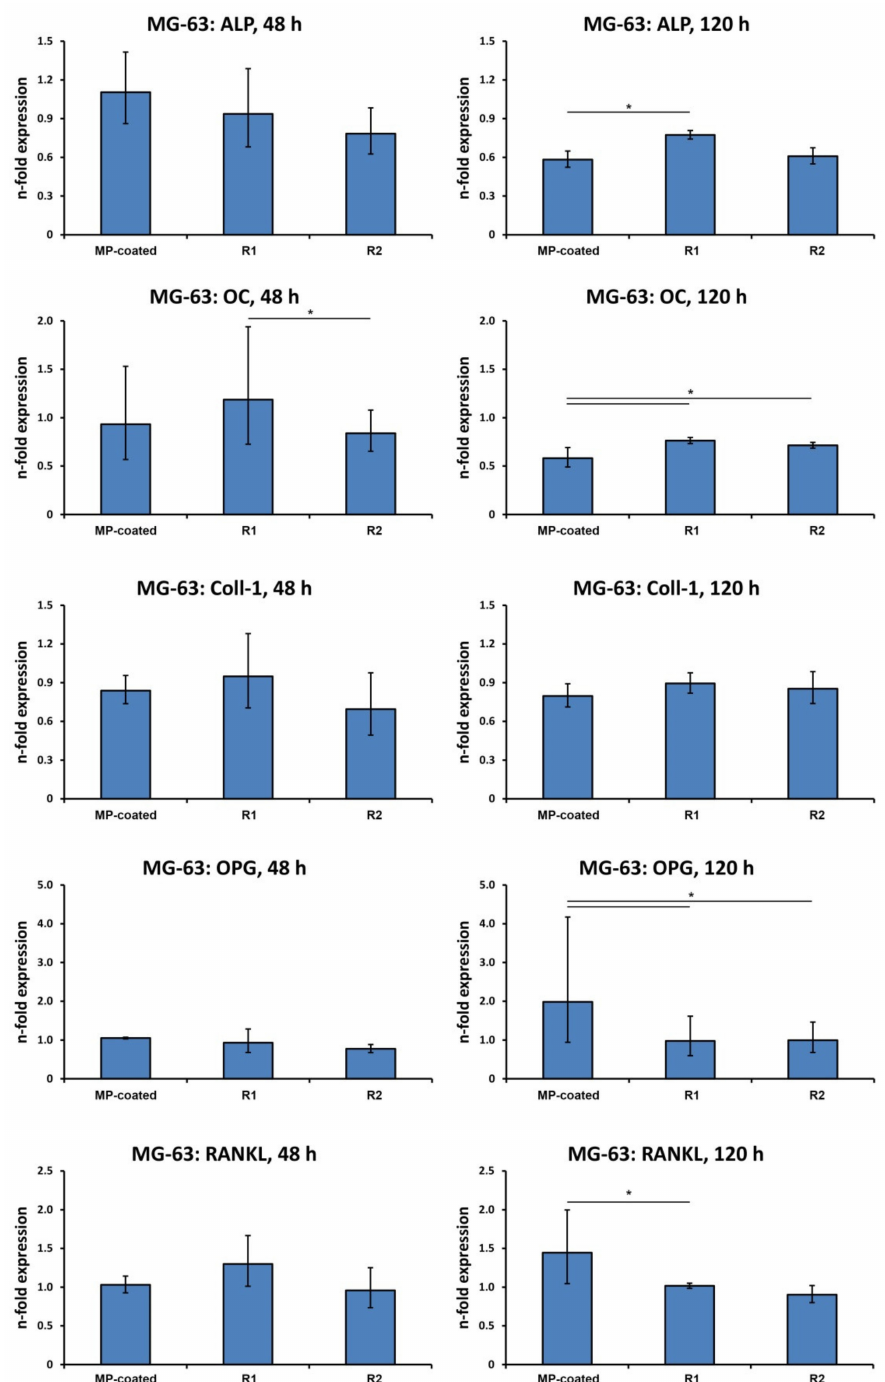
Figure 3. Expression of genes related to osteogenesis and bone turnover in MG-63 cells grown on titanium surfaces.MG-63 cells were cultivated on multi-phosphonate (MP)-coated, sand-blasted, and acid-etched reference surfaces (R1, R2) and tissue culture plastic (TCP) for 48 and 120 h, and gene expression of alkaline phosphatase ALP, osteocalcin OC, collagen type I (Col1), osteoprotegerin (OPG), and receptor activator of NF- κ B ligand (RANKL) was assessed by quantitative real-time PCR. Y-axis represents n-fold expression related to the MG-63 cells cultivated on TCP calculated using the 2 − ∆∆ Ct method, using glyceraldehyde 3-phosphate dehydrogenase (GAPDH) as a housekeeping gene. Data are presented as the mean ± S.E.M of four experiments that were conducted independently *—significantly di ff erent between groups, p <